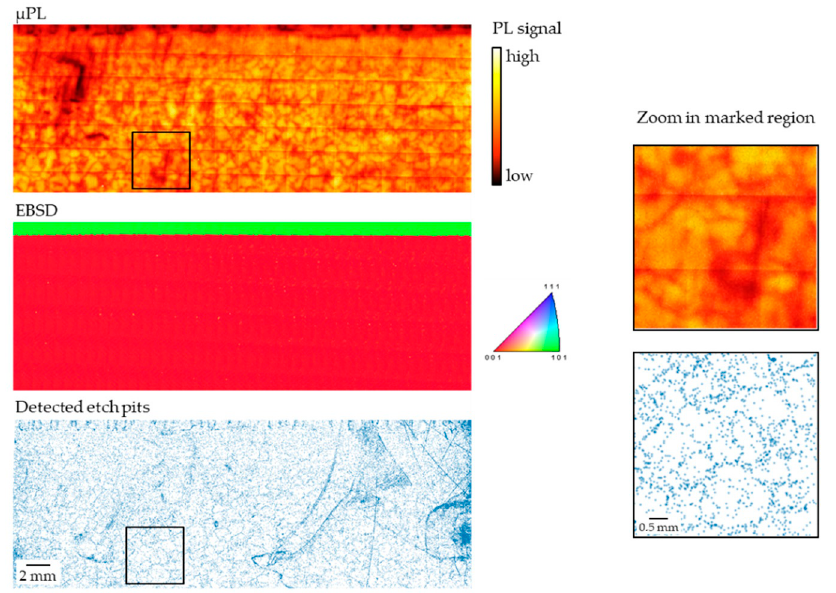
Figure 6. µPL map of functional defects surrounding mono area at 28 mm ingot height ( top ), grain orientation mapping of the direction perpendicular to the wafer surface at 32 mm ingot height ( middle ) and detected etch pits (EPD) after Cr-less etch at 28 mm ingot height ( bottom ).